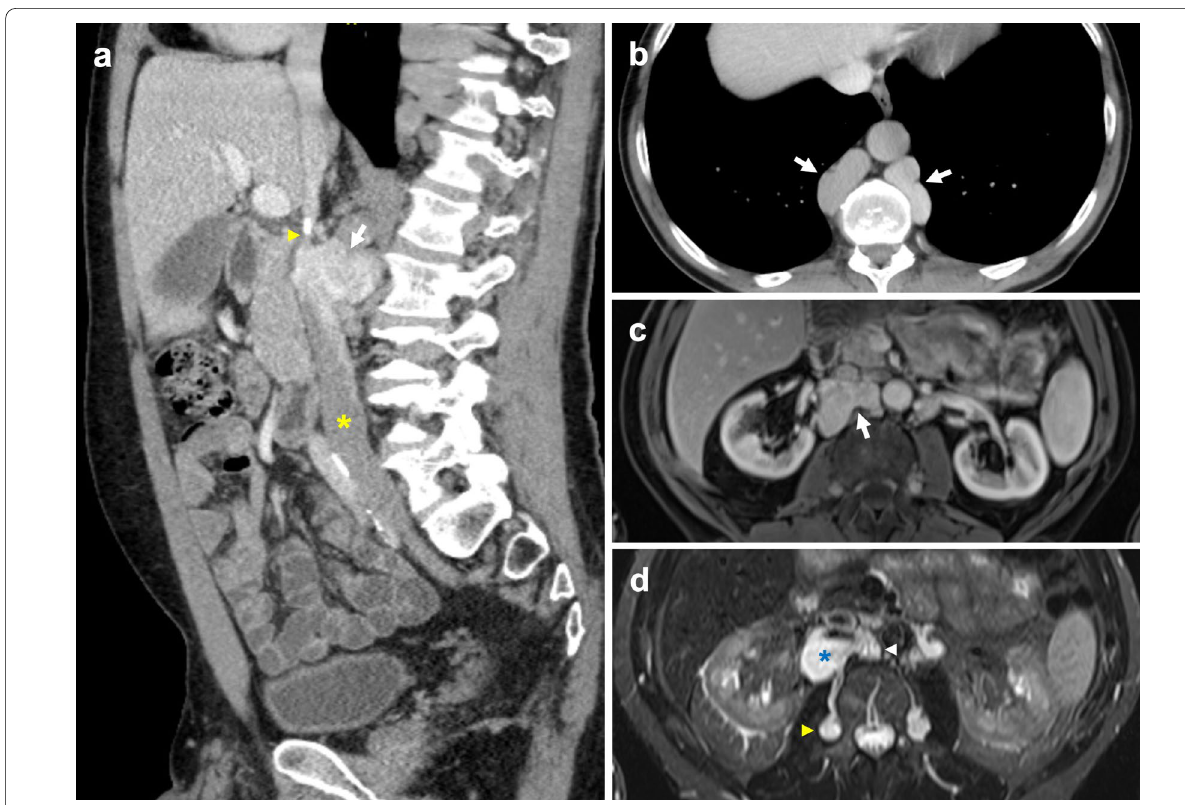
Fig. 9 Distended collateral vein mistaken for mass in context of incidentally detected suprarenal IVC stenosis. The 54-year-old man had no previous history of IVC filter insertion or intrabdominal surgery. a Contrast-enhanced sagittal CT shows a pseudomass (arrow) immediately posteroinferior to complete stenosis (arrowhead) of the suprarenal IVC, with caudal segments of the IVC (asterisk) preserved. A small focus of calcification is present at the level of the stenosis. b Axial CT shows preferential blood flow through markedly distended azygos and hemiazygos veins (arrows). c Axial MR T1 VIBE image shows a well-defined lobulated mass (arrow) with venous enhancement. d Axial MR T2 image of the mass (asterisk) shows high T2 signal in keeping with slow venous flow. It communicates posteriorly with the right ascending lumbar vein (yellow arrowhead) and medially with a right paravertebral collateral vein (white